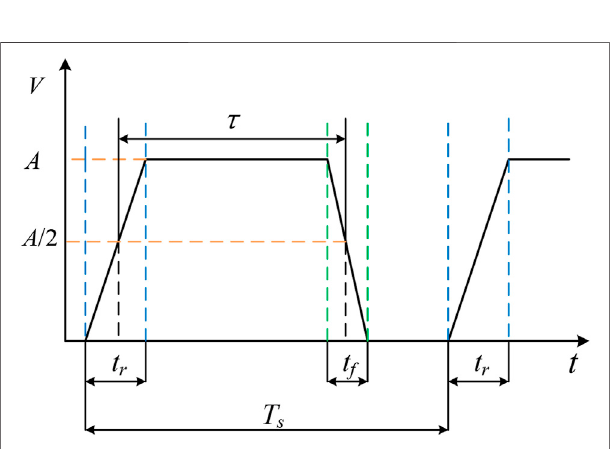
FIGURE 1 | Structure of the Si/SiC hybrid switch-based boost converter.